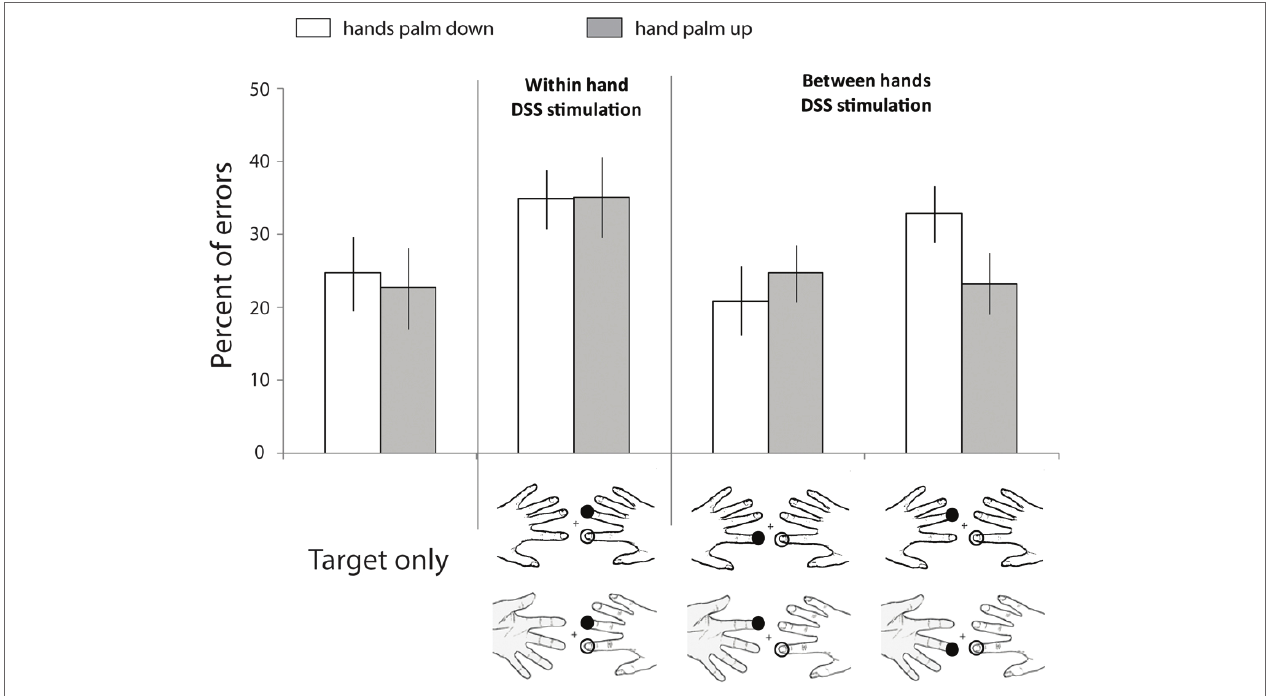
FIGURE 1 | Spatial coding of touch at the fingers. Data retrieved from Tamè et al. (2011) study in which participants performed a speeded go-no-go task to indicate whether the target finger had been stimulated or not. Across conditions, the target finger was presented alone or concurrently with a masker (double simultaneous stimulation, DSS) on another finger (i.e., other finger of the same hand, homologous finger of the opposite hand, non-homologous finger of the opposite hand). Moreover, in different blocks, participants assumed different postures (i.e., hands palm down or hand palm up). Unfilled circles: Stimulation at the target finger; filled black circles: stimulation at the non-target finger. Bar plots show percent errors as a function of stimulation condition and hands’ posture. Error bars represent the standard error of the mean (±SEM). Adapted from Tamè et al. (2011). © 2011 by Elsevier. Permission for the use of the image has been obtained from the